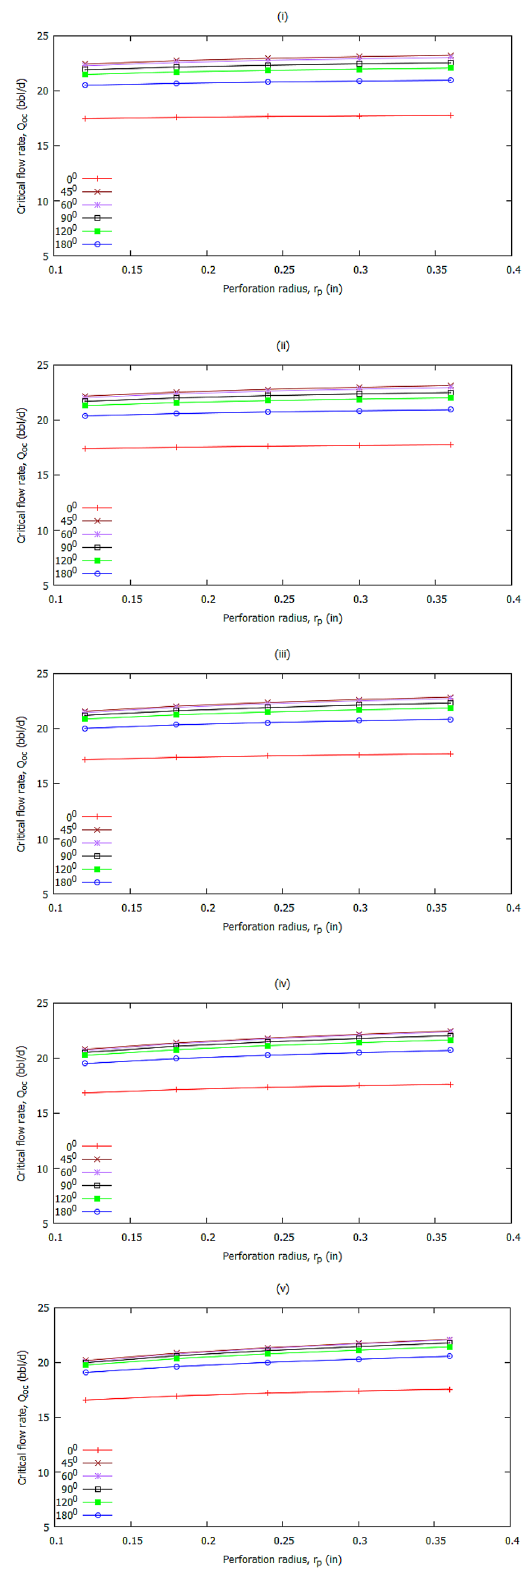
Fig. 8 Perforation length of 48 in and spacing between perforations on critical flow rate at different phasing angles and perforation radius. i Spacing between perforations at 1 in, ii Spacing between perfora- tions at 1.2 in, iii Spacing between perforations at 1.7 in, iv Spacing between perforations at 2.4 in and v Spacing between perforations at 3 in